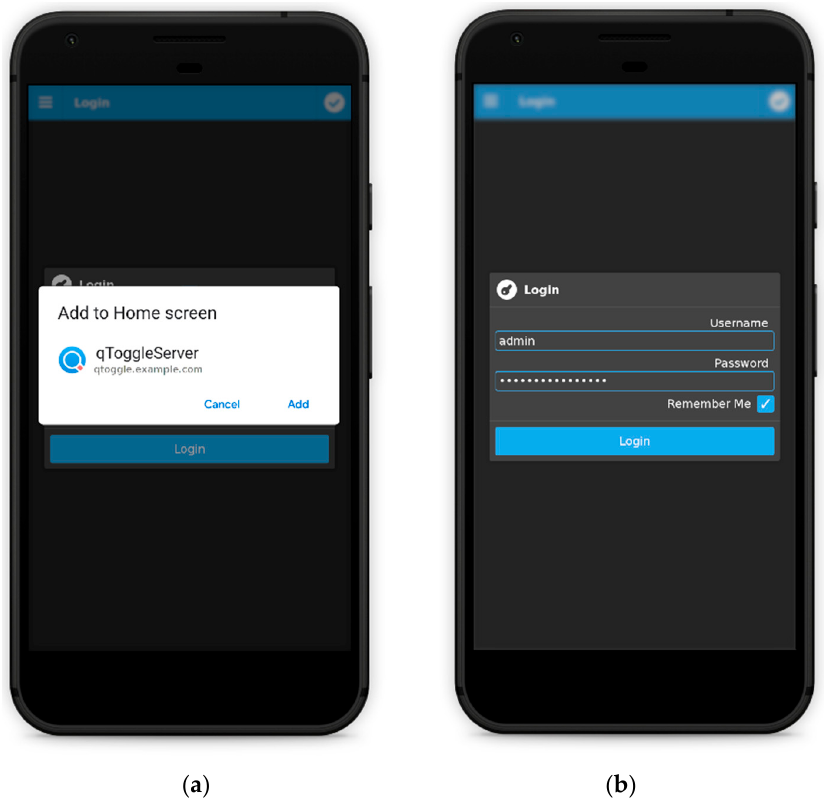
Figure 3. Logging in for the first time on qToggleServer ( a ) and setting used and password ( b ).